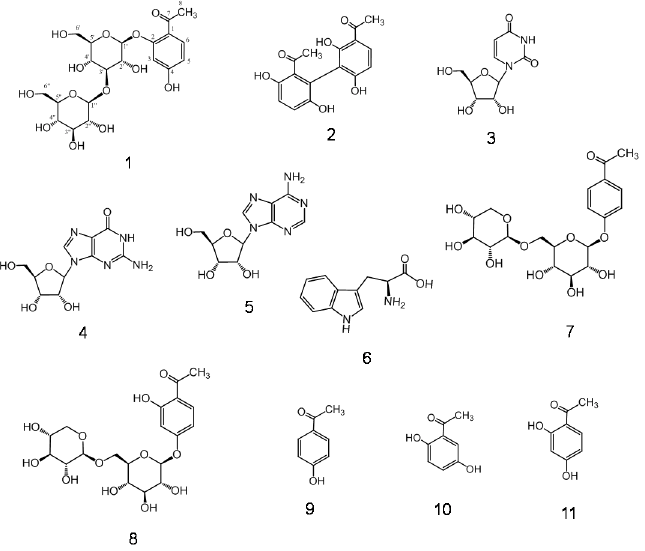
Figure 1. Structures of compounds 1 – 11 .